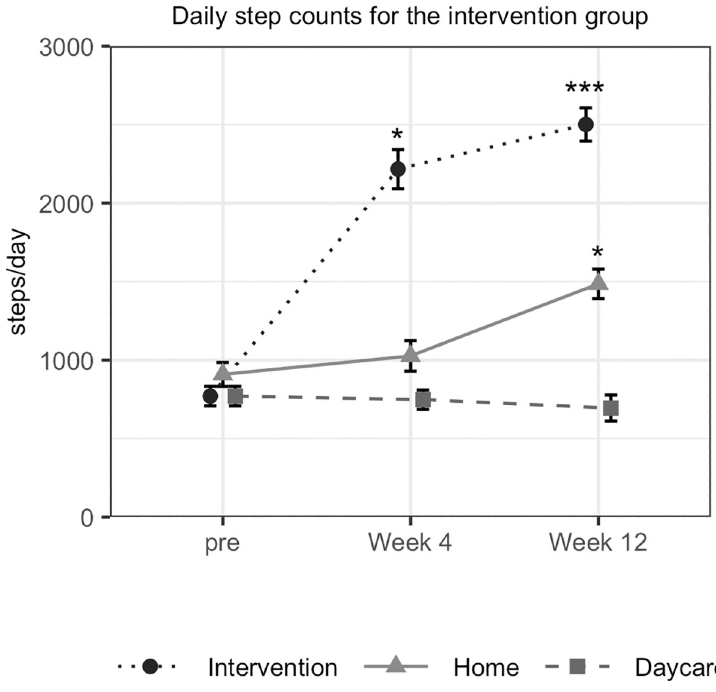
Fig 3. Daily step counts by